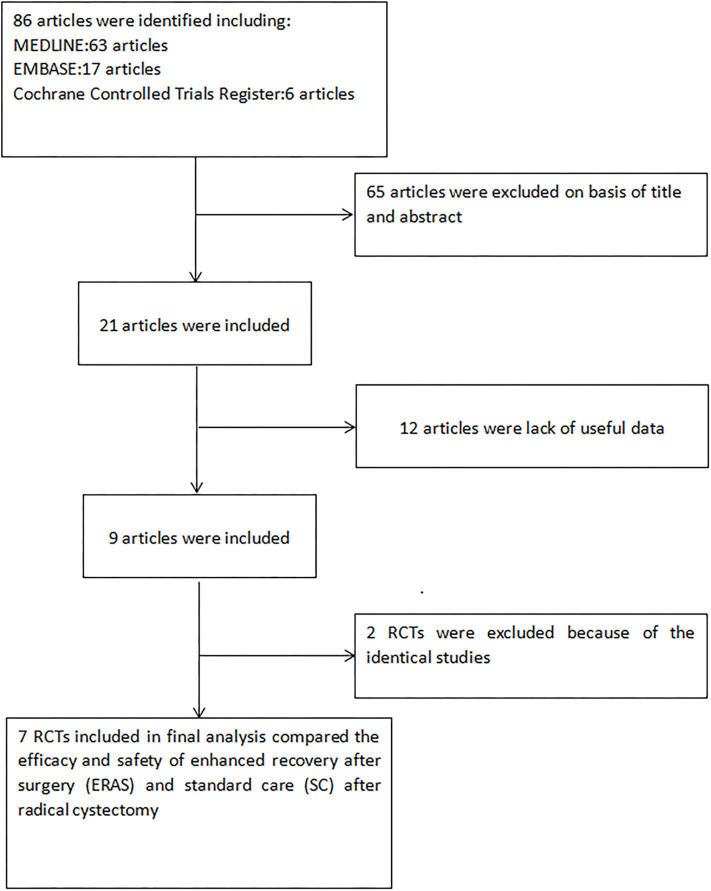
Flowchart of the study selection process. RCT, randomized controlled trials; ERAS, enhanced recovery after surgery; CRAS, conventional recovery after surgery.